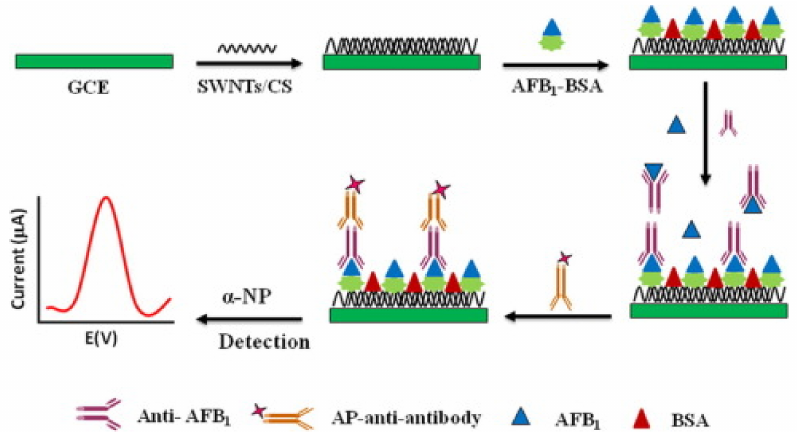
Figure 7. Scheme of the strategy for AFB1 sensing using a GCE modified with an SWCNTs/CHI film. Reprinted with the permission from reference [93]. Copyright 2016